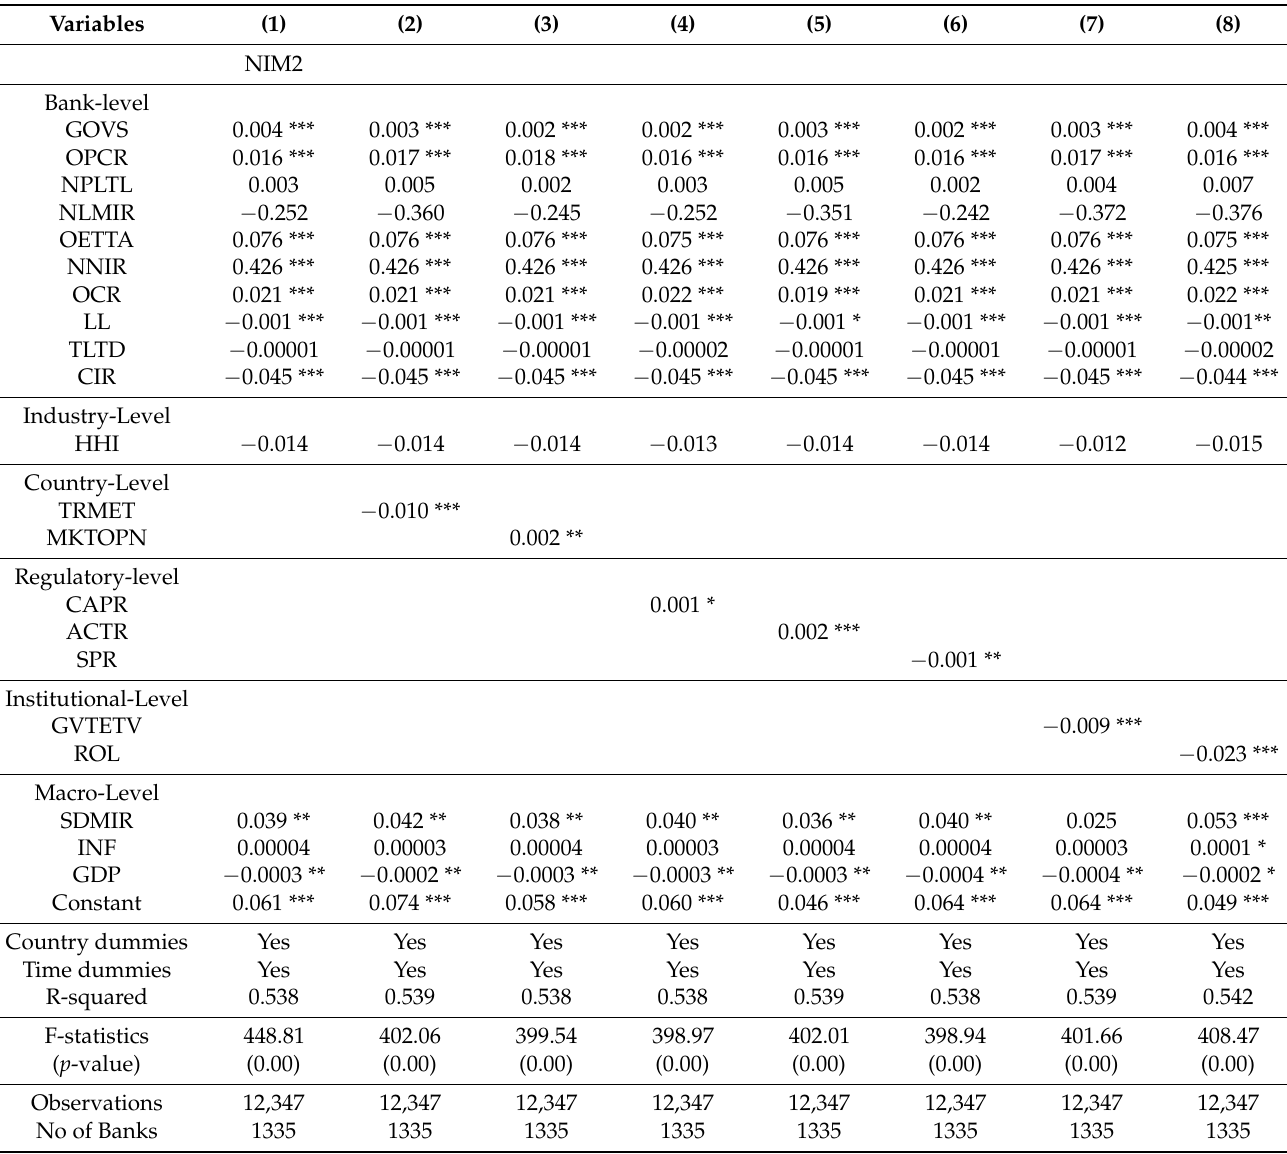
Table 5. Elasticity: Alternative variables (NIM2 and OPCR instead of NIM1 and